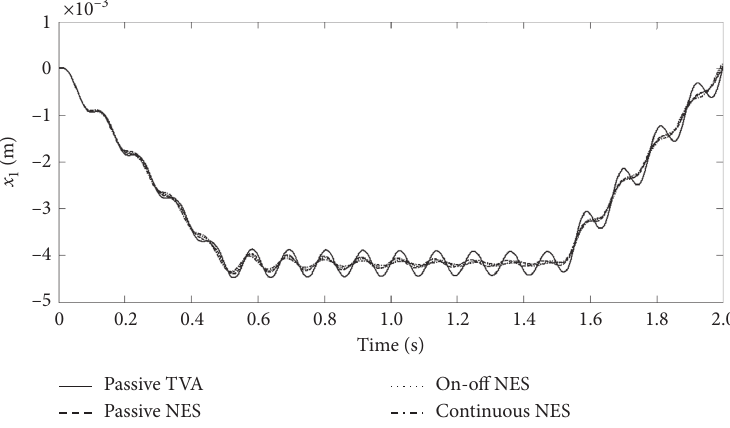
Figure 7: Displacement of main